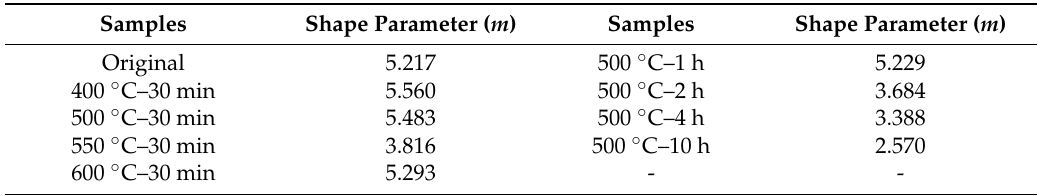
Table 3. Shape parameter ( m ) of carbon